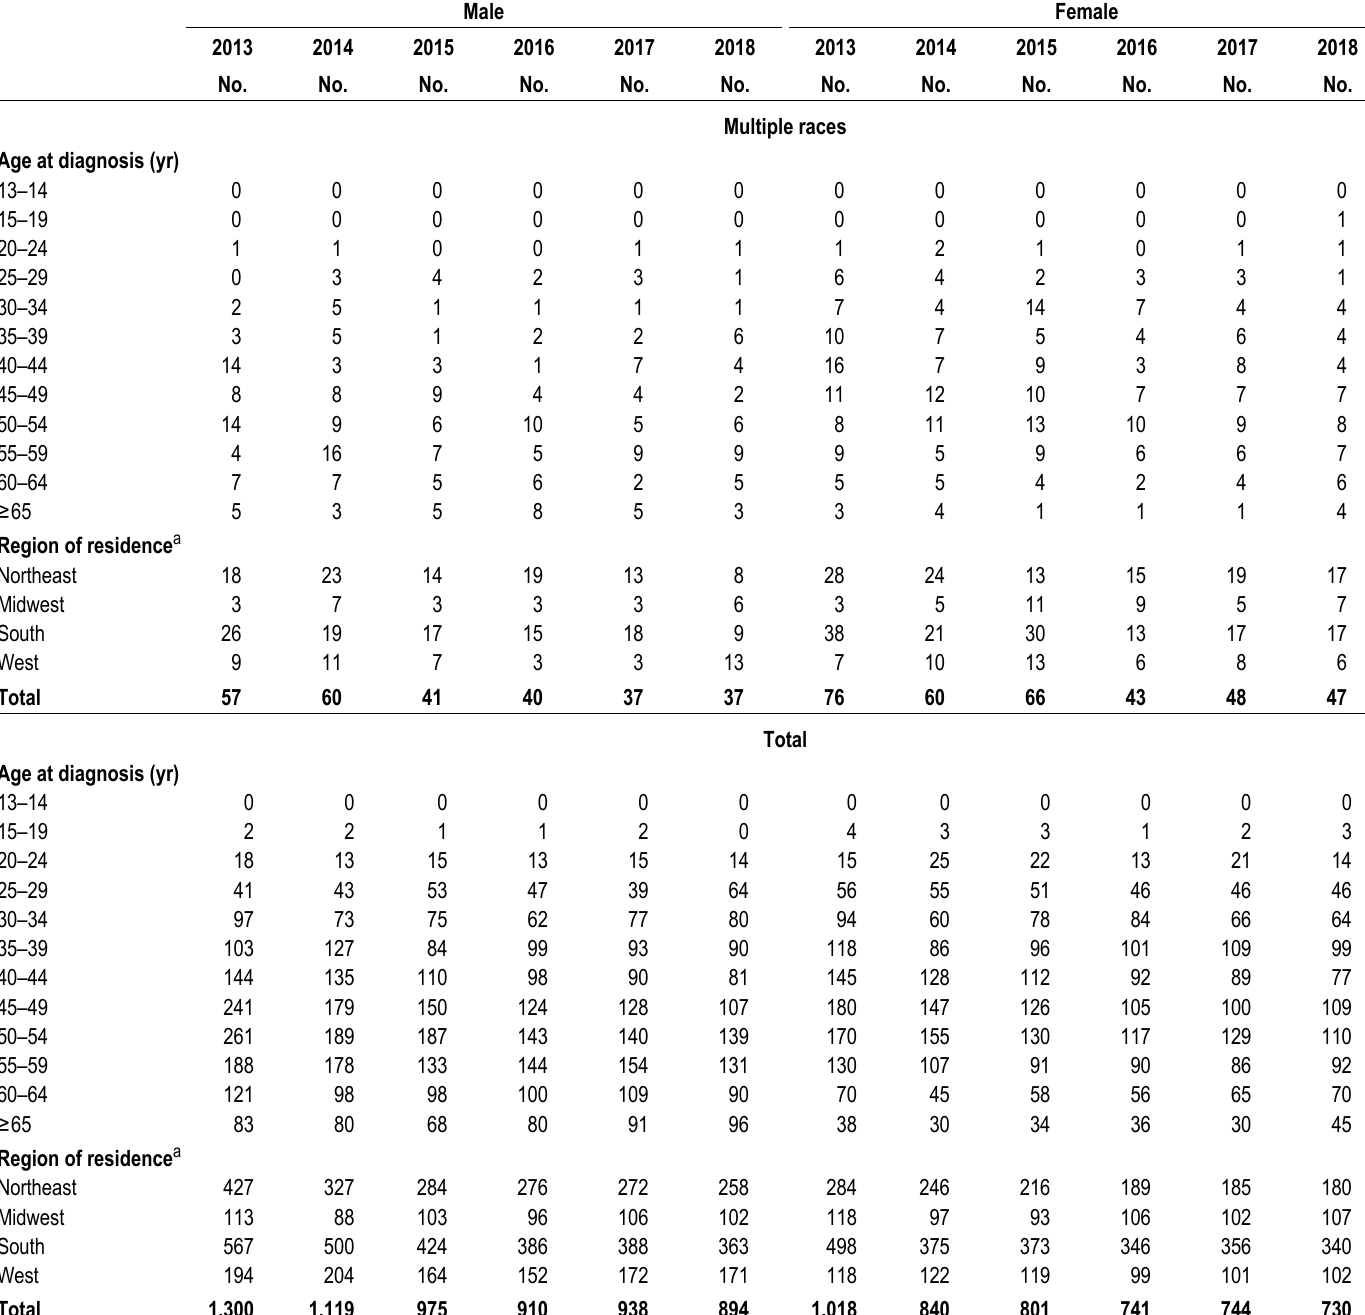
Table 11a. Stage 3 (AIDS) attributed to injection drug use, by selected characteristics, 2013–2018—United States